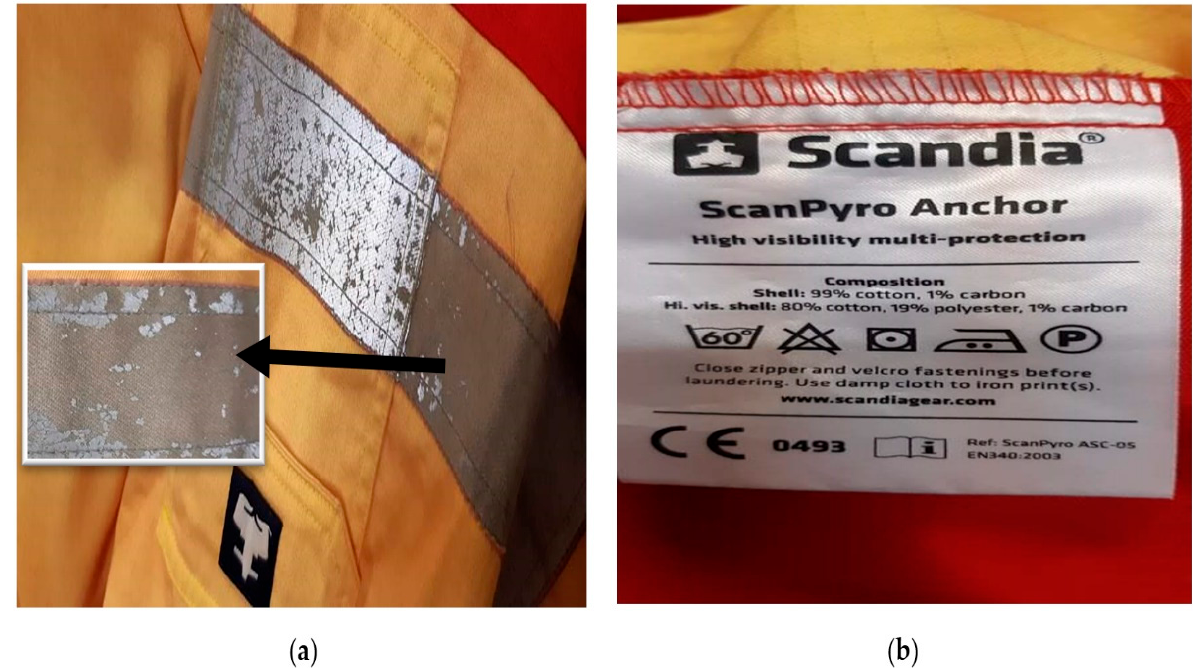
Figure 6. The author captured pictures onboard during sampling. The photos are of ( a ) complete damage to the reflective coating after the first washing cycle and ( b ) the ScanPyro Anchor instruction of the seaman’s overalls at the top, according to which washing is carried out on board.